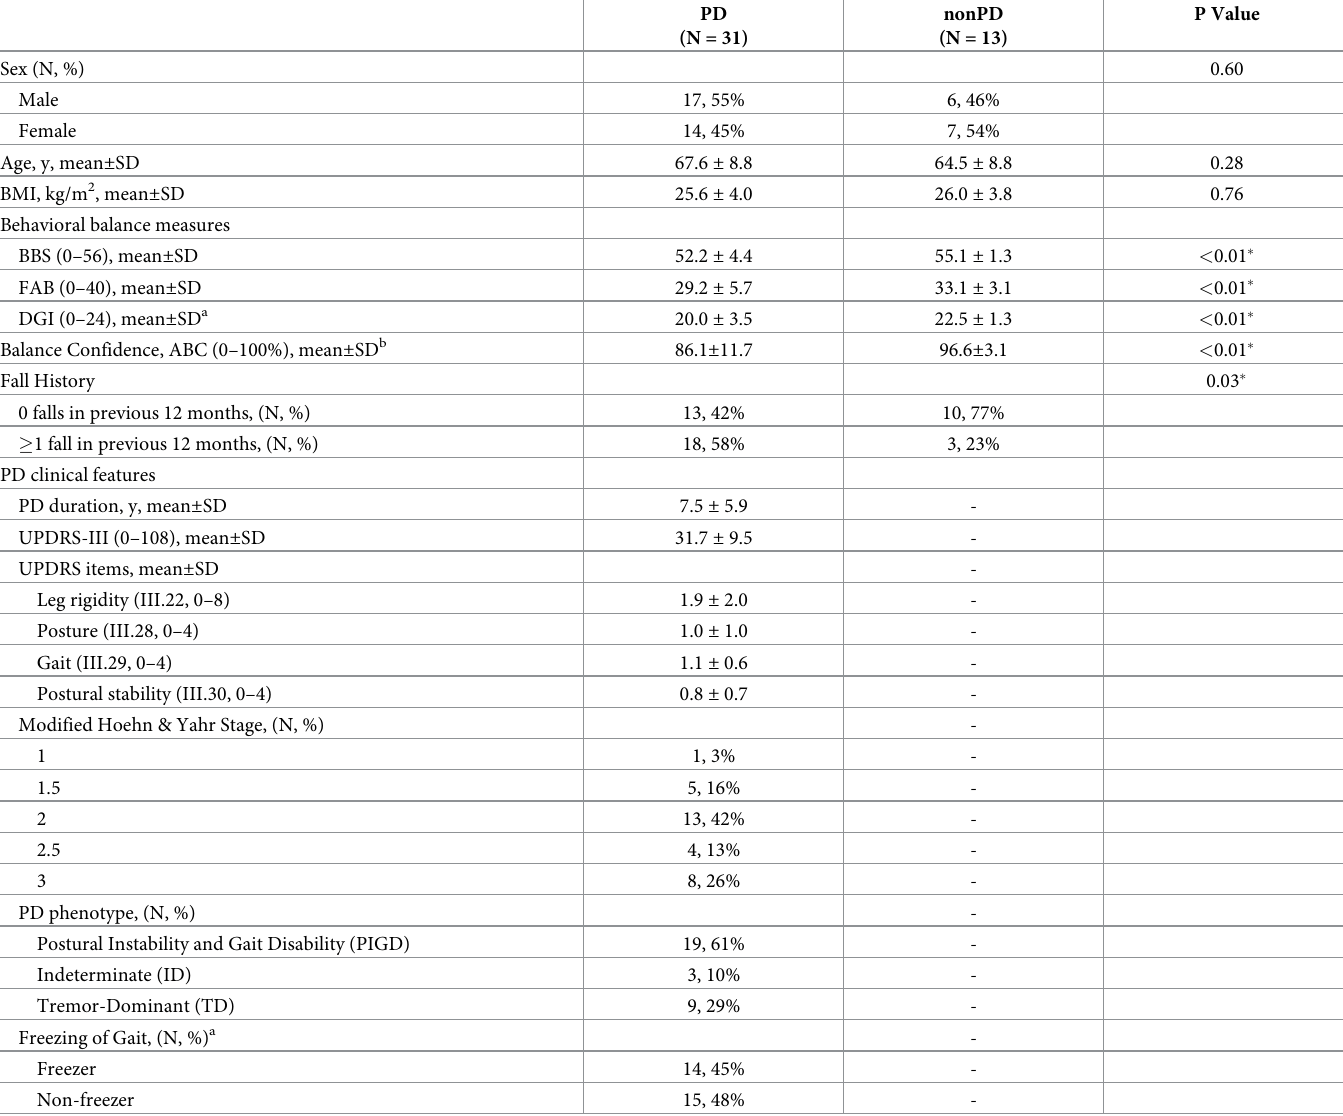
Table 1. Demographic and clinical characteristics of study participants with and without Parkinson’s disease